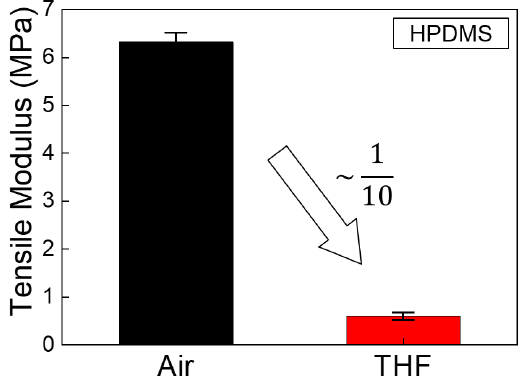
Figure 5. Tensile modulus of HPDMS in air and in THF.